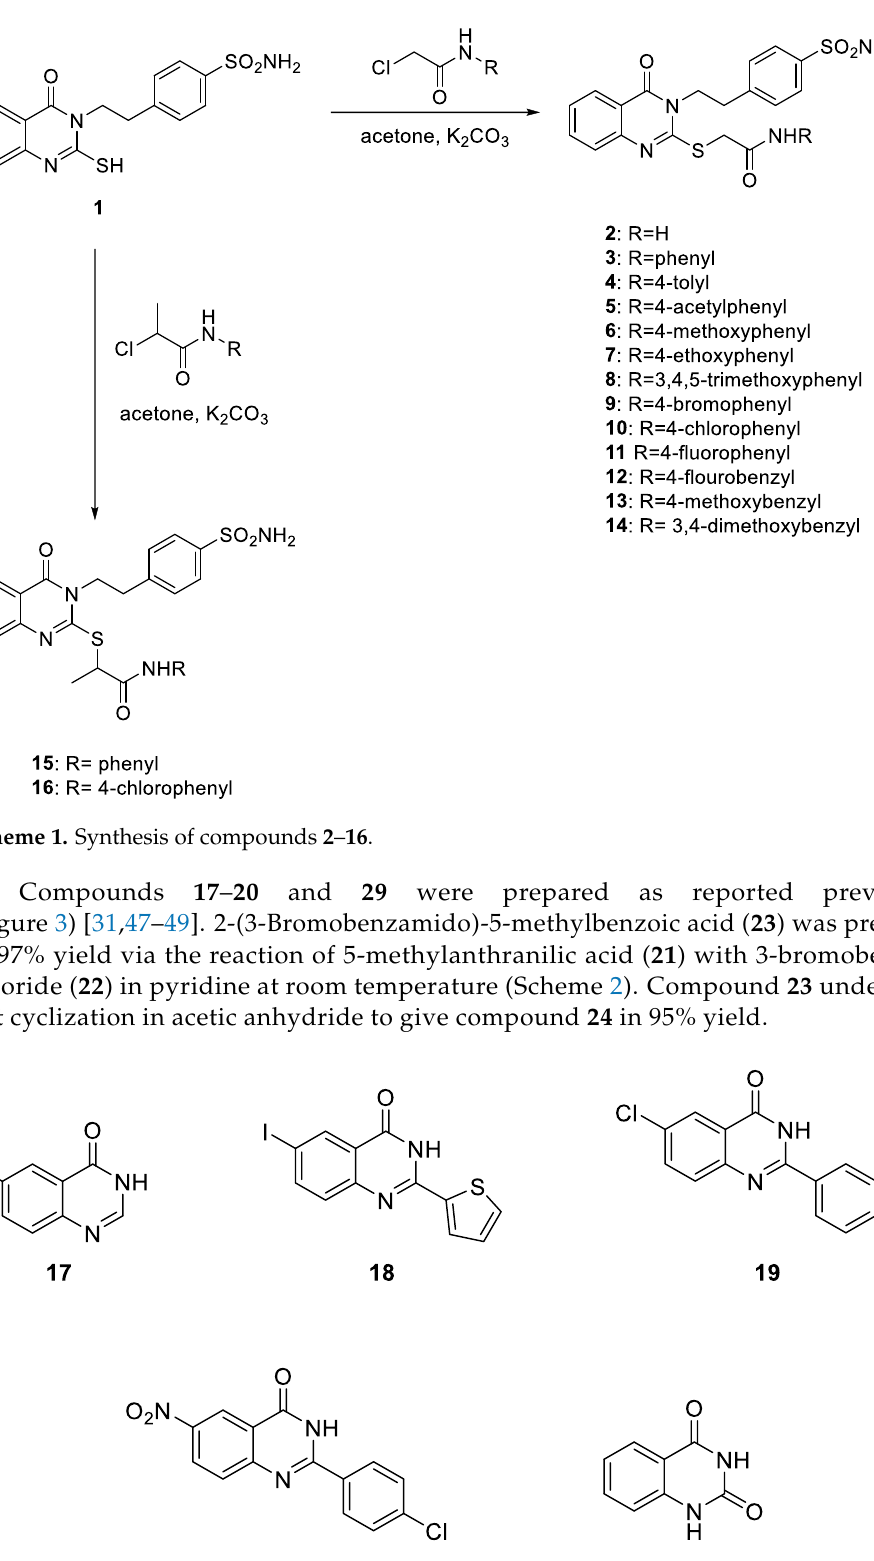
Figure 3 . Structures of compounds 17 - 20 and 29 .